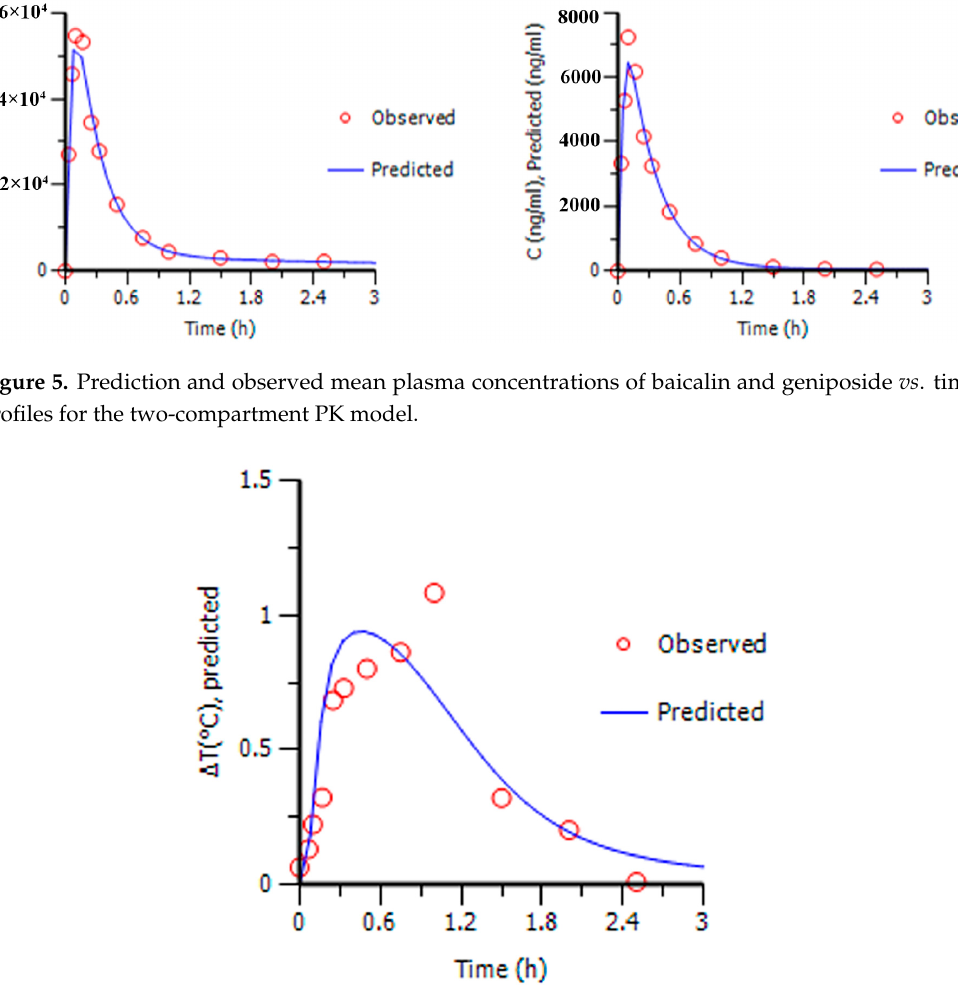
Figure 6. Prediction and observed mean antipyretic effect vs. time profiles for Sigmoid E max